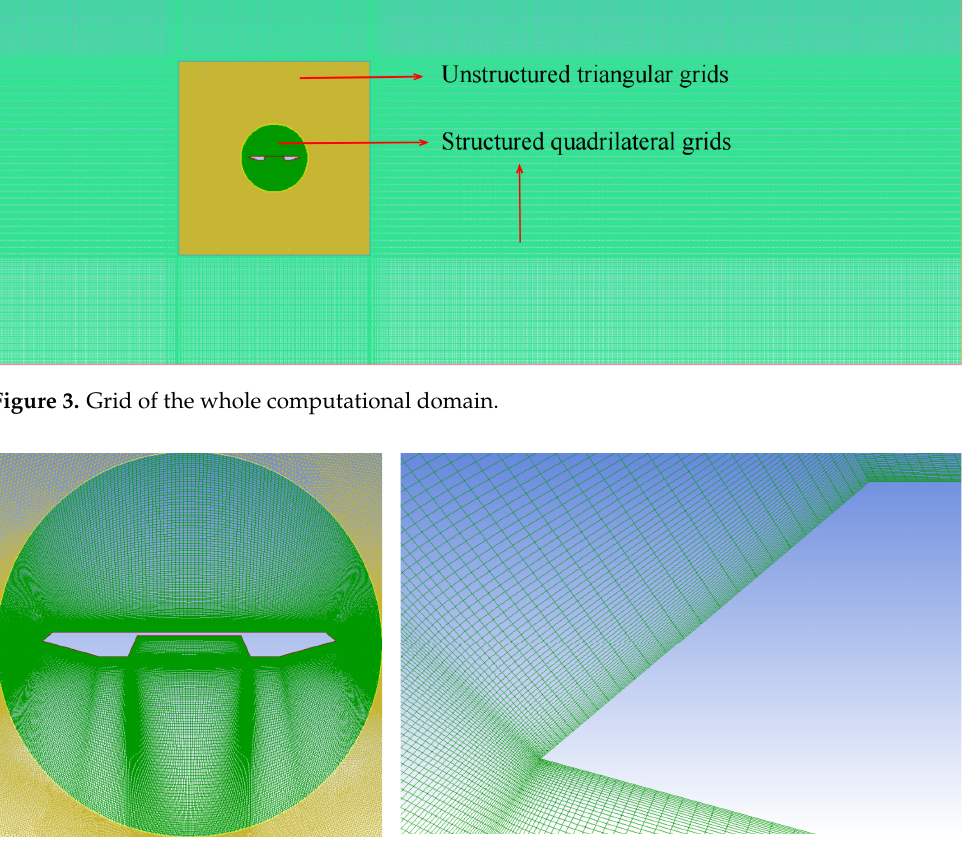
Figure 4. Grid of Local details. ( a ) Rigid moving region ( b ) Front edge near wall.